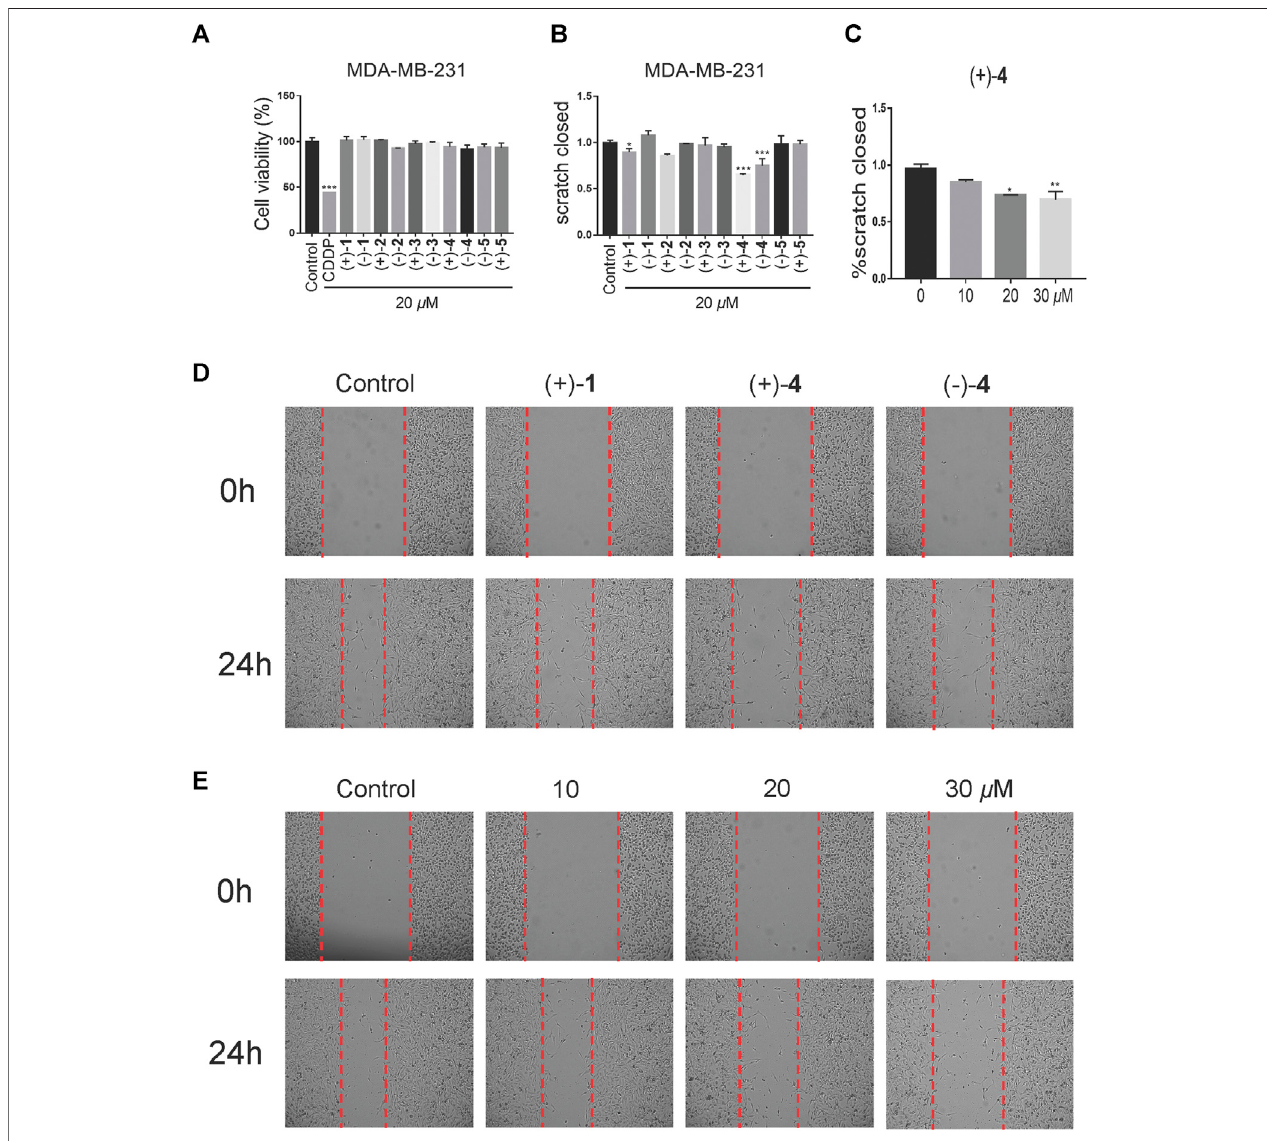
FIGURE 7 | Effects of compounds on cell migration at low-toxicity doses. (A) Cell viability of MDA-MB-231 was treated with the vehicle or 20 μ M compounds for 48 h ( n (cid:1) 3). (B) Wound healing assay of the MDA-MB-231 cell line, treated with the vehicle or 20 μ M compounds for 24 h ( n (cid:1) 3). (C) The dose-dependent migratory inhibitioneffectofthecompound(+) - 4 . (D) Representativepicturesofcompounds(+) - 1 (+) - 4 and( – ) - 4 at20 μ Mfor24 hofMDA-MB-231. (E) Representativepicturesof compound (+) - 4 at different doses for 24 h in MDA-MB-231 cells. Data are of three replicates ( n (cid:1) 3) * p < 0.05, ** p < 0.01, one-way ANOVA.